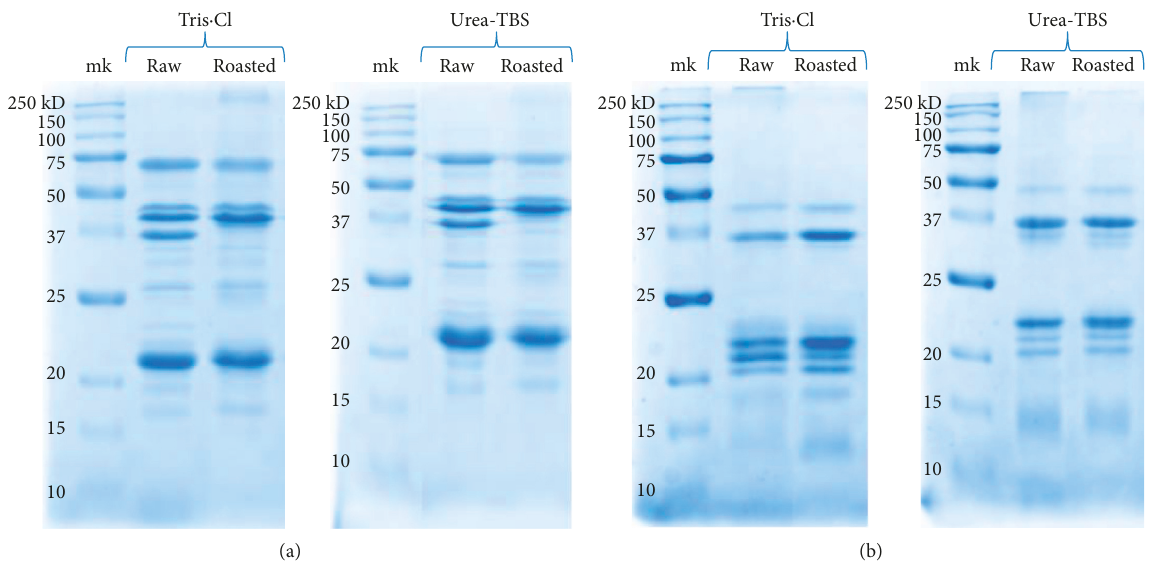
Figure 2: Typical electrophoretic profile of raw and roasted samples extracted with Tris · Cl and urea-TBS buffers (SDS-PAGE, 15% ac- rylamide gel). (a) Comparison of peanut protein profiles extracted with Tris · Cl and urea-TBS. (b) Comparison of hazelnut protein profiles extracted with Tris · Cl and urea-TBS. The first lane refers to protein markers (mk) for molecular weight